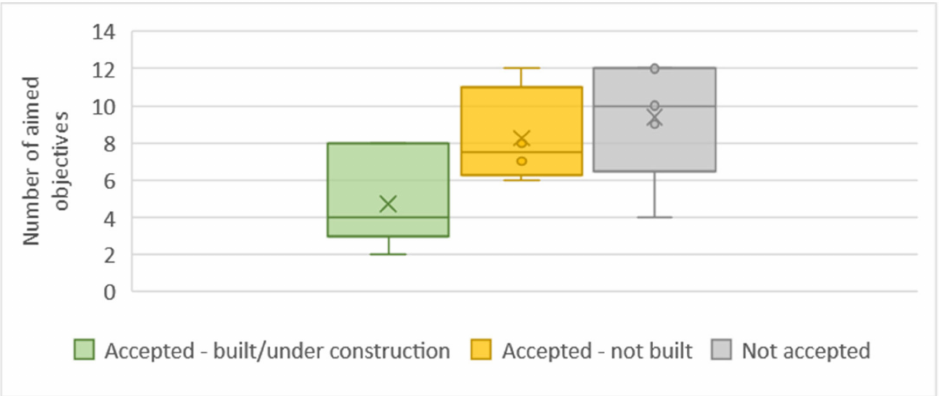
Figure 8. Distribution of the total number of aimed objective in the projects per project